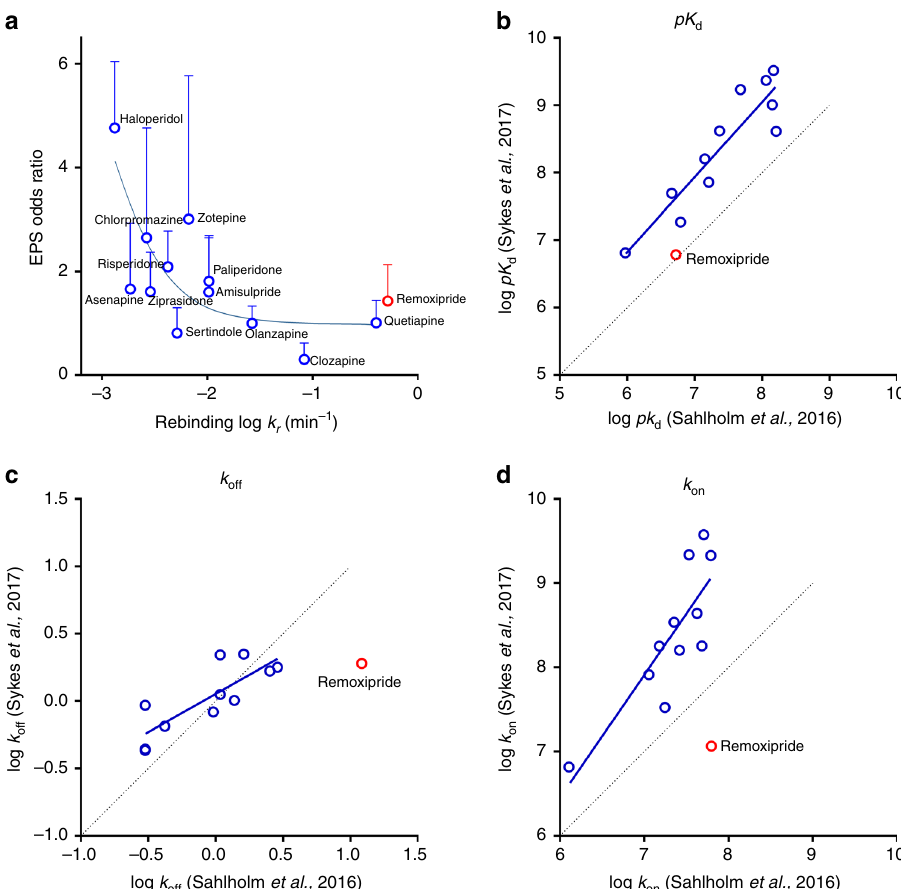
Fig. 1 Comparison of kinetic binding data. a Correlation of EPS odds ratio with the rebinding reversal rate, reproduced from Sykes et al. 2 to include the new odds ratio calculated by Zeberg and Sahlholm 1 . b – d Comparison of b p K d , c k off , and d k on values at the dopamine D2 receptor calculated using the GIRK channel assay of Sahlholm et al. 4 and TR-FRET assay of Sykes et al. 2 It should be noted that the study by Sahlholm et al. 4 was performed at 20 – 22 °C whilst the study of Sykes et al. 2 was performed at 37